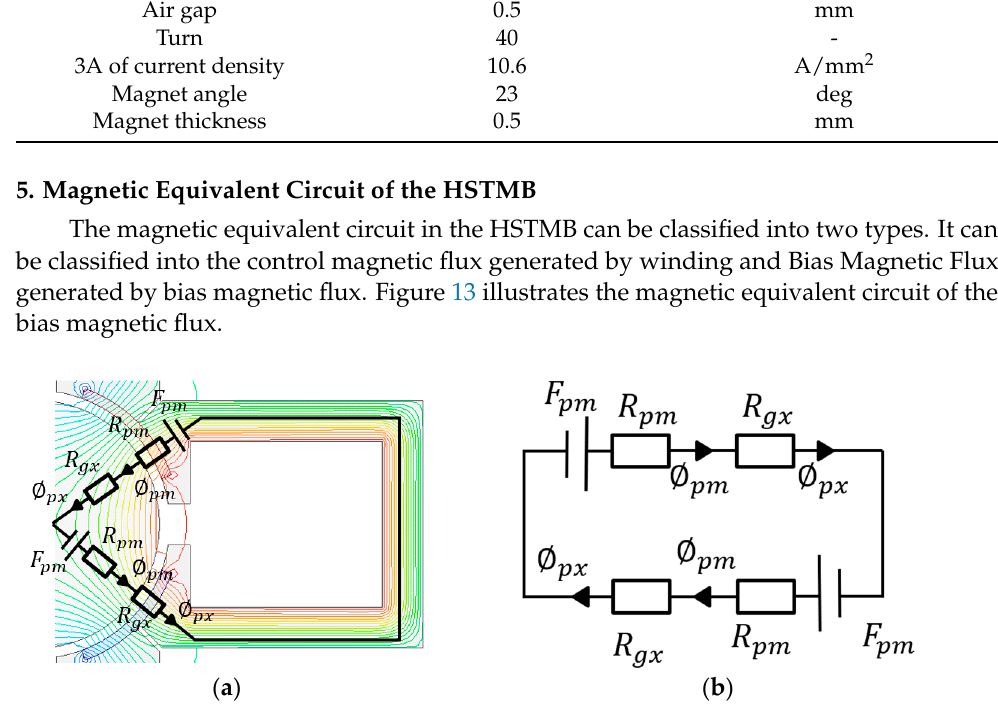
Figure 13. Magnetic equivalent circuit of bias magnetic flux of the HSTMB: ( a ) magnetic equivalent circuit and ( b ) the simplified magnetic equivalent circuit.